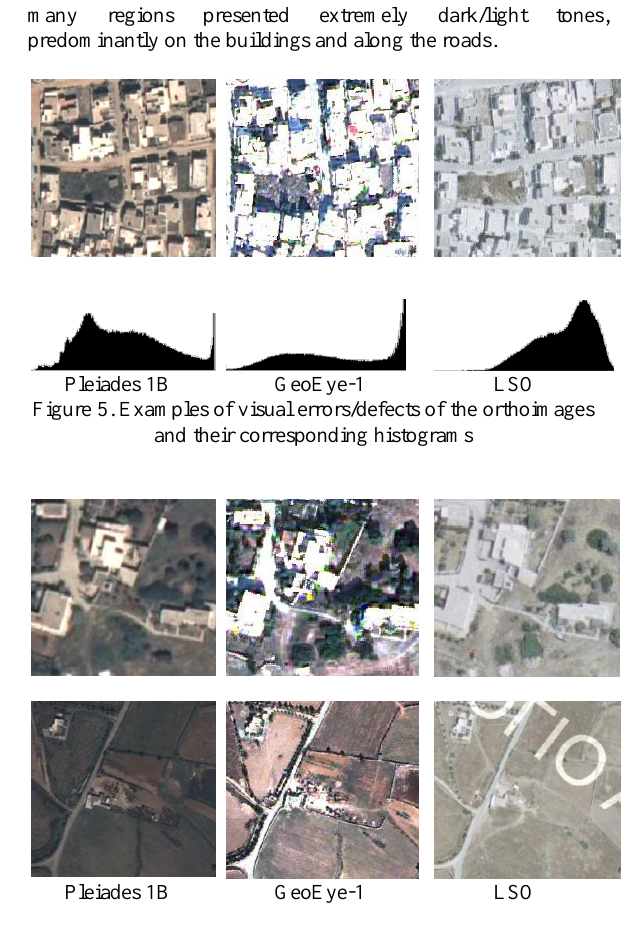
Figure 6. Examples of visual errors/defects of the